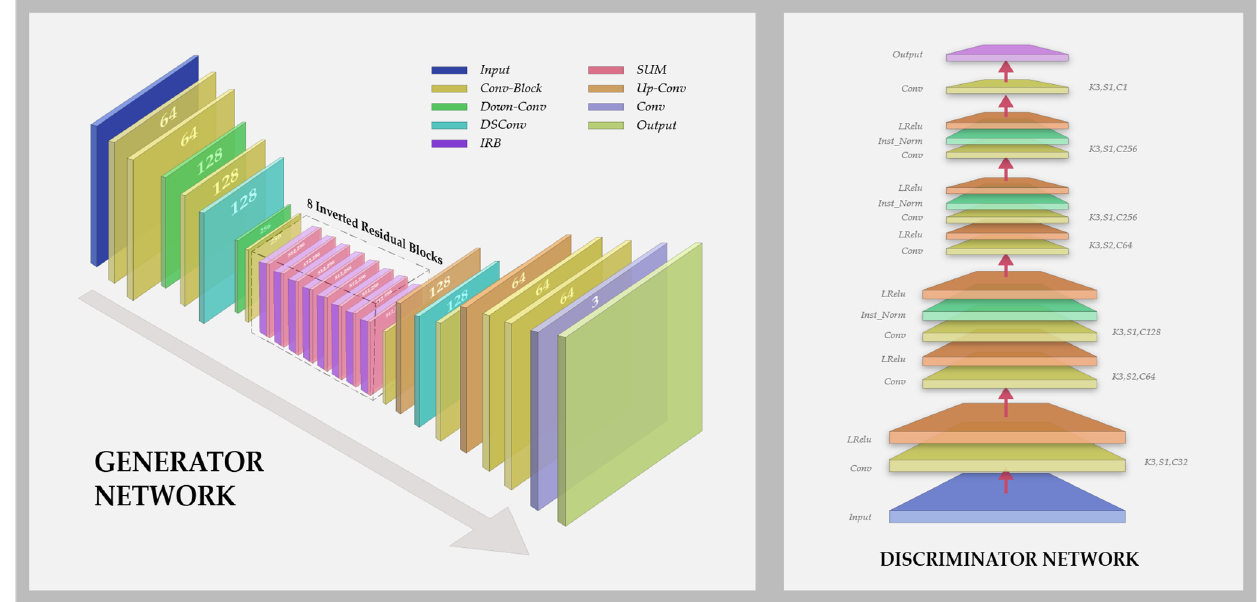
Figure 6. Model’s architecture.